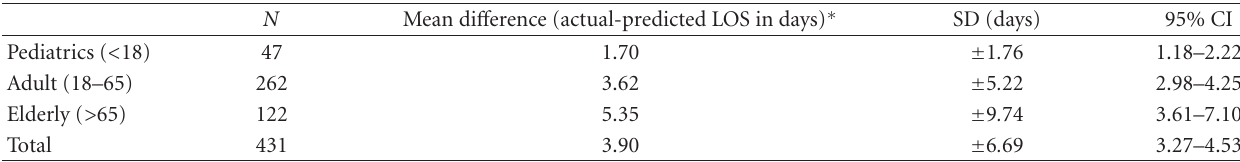
Table 1: Patient data by the separate age groups with the mean, SD, and 95% CI.